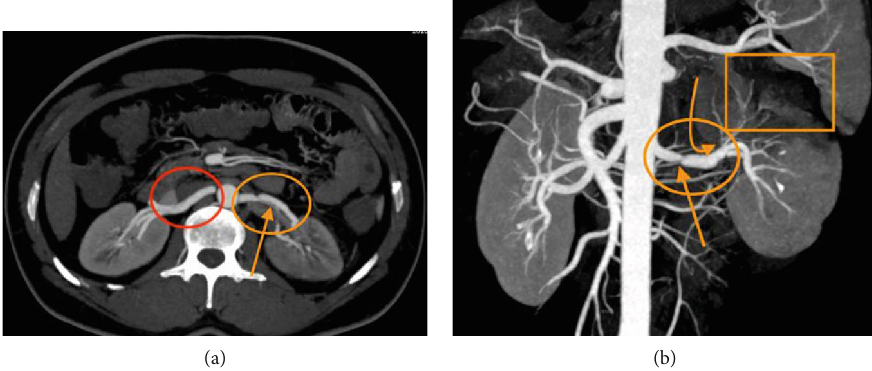
Figure 1: (a) Axial MIP CT image and (b) anterior volume-rendered 3D MPR coronal image were obtained after intravenous contrast material in arterial phase demonstrates focal thrombosis in the mid-left main renal artery (orange circle) and dissection fl ap (straight orange arrow in a), causing signi fi cant stenosis (orange straight arrow in b) and near-complete nonopaci fi cation of the upper segmental branch of the left renal artery for a length of approximately 3 – 4mm with narrowed caliber and attenuated fl ow in the rest of the segmental and subsegmental branches (angled orange arrow in b), resulting in patchy cortical nonenhancement, predominantly involving the upper half and few discrete areas in the lower half of the left kidney, suggestive of infarct (orange rectangular in b), and also demonstrates normal right renal artery (red circle in